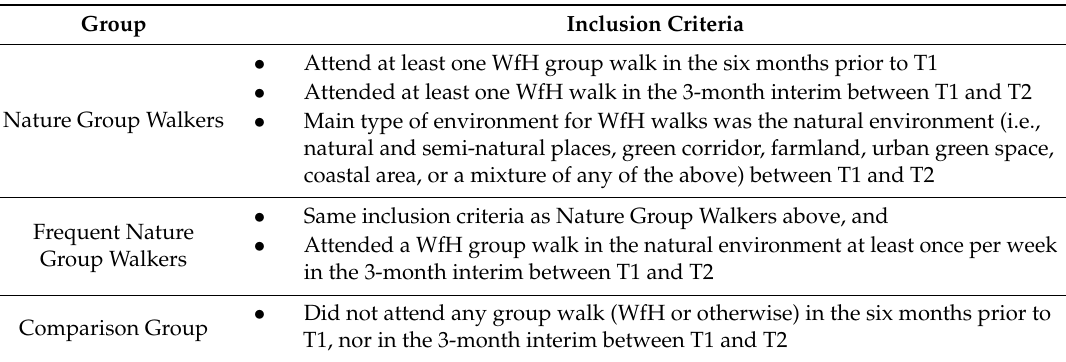
Table 2. Inclusion criteria for participant groups in the current